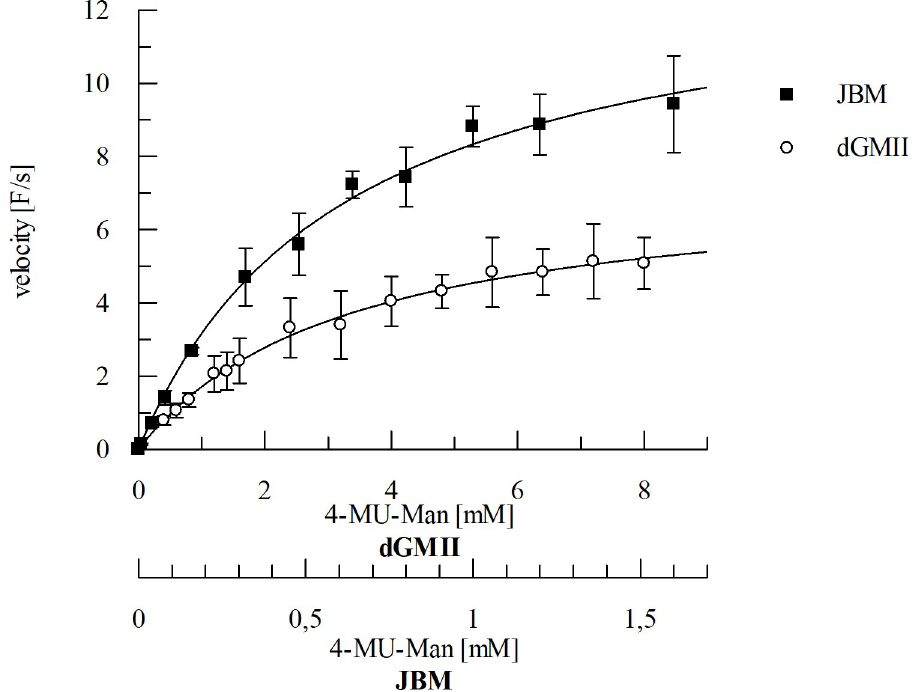
Fig 5. Example of the non-linear fit for the determination of the K M values of the enzymes dGMII and JBM with 4-MU-Man as substrate. Non-linear regression was applied to the data using the Michaelis-Menten Eq (3).